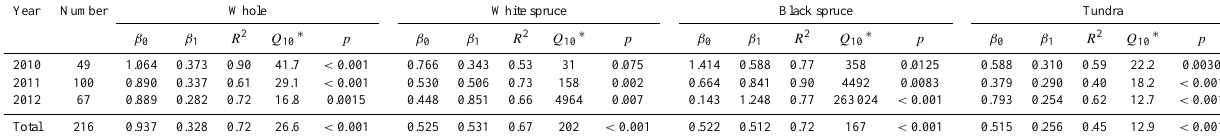
Table 3. Constants and correlation coefficients in the exponential equation for soil CO 2 efflux response to soil temperature at 5cm below the surface in white spruce, black spruce, and tundra sites across the haul road of Alaska during the spring seasons of 2010–2012, for which the equation is CO 2 efflux = β 0 · e (β 1 · T) , based on a one-way ANOVA at the 95% confidence level.